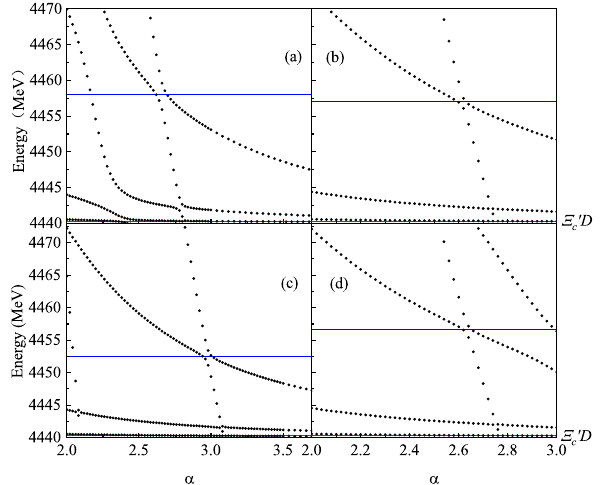
Table 8 The decay width of P cs states in 0 3